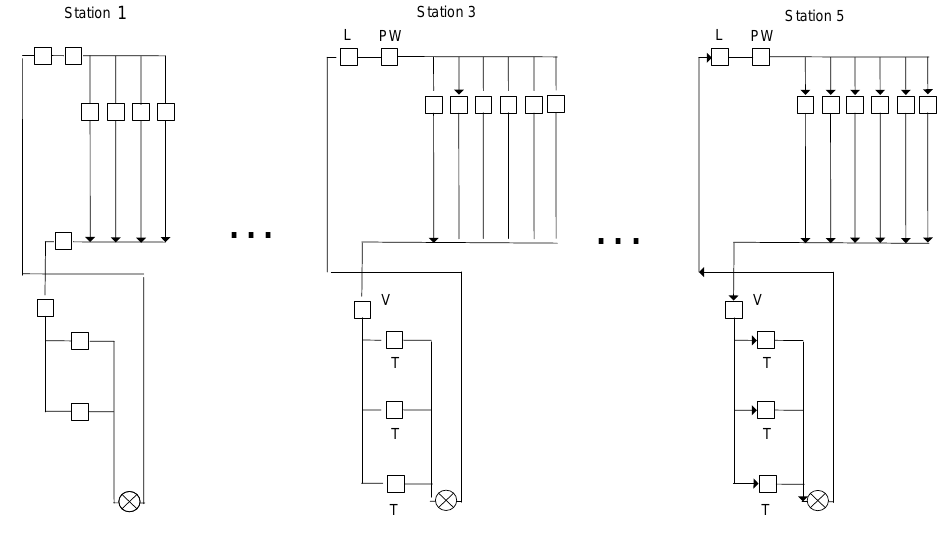
Figure 5. “Independent zone layout (IZL)”. Source: Jeong and Hong